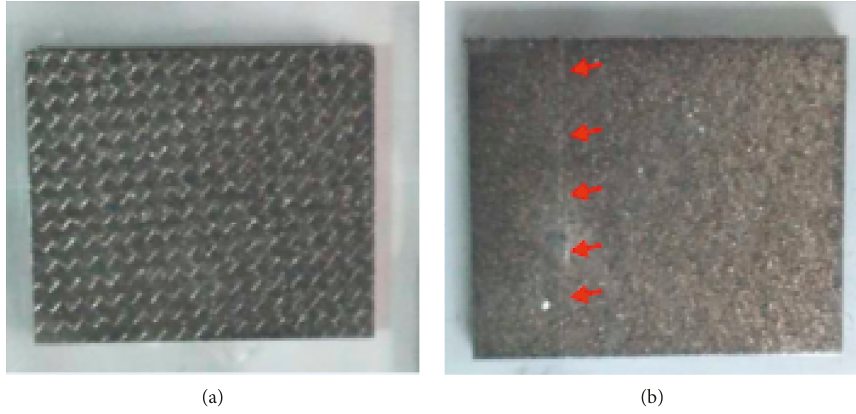
Figure 4: The surface quality of the specimen. (a) Chessboard scanning. (b) Uniformity